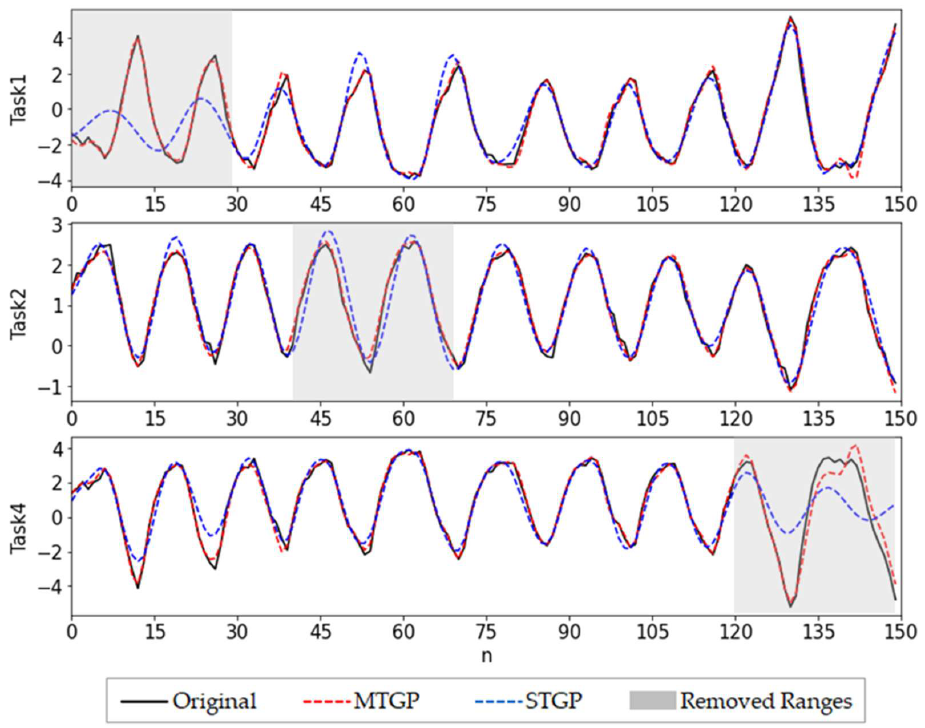
Figure 6. Imputation results of MTGP and STGP for S2.